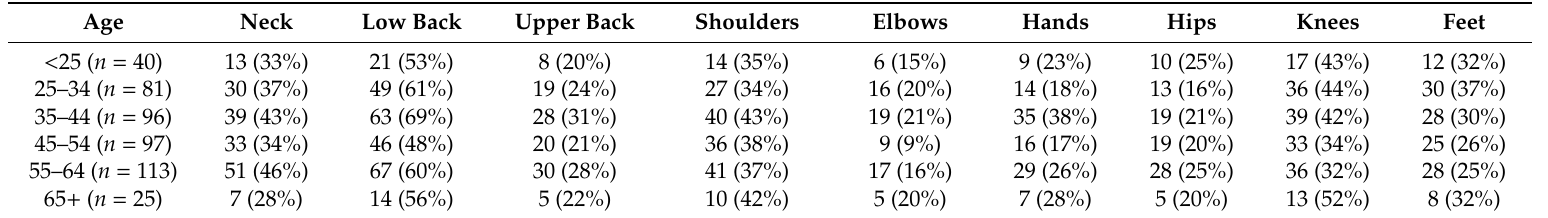
Table 2. Prevalence of reported 12-month musculoskeletal symptoms (MSS) stratified by age group.